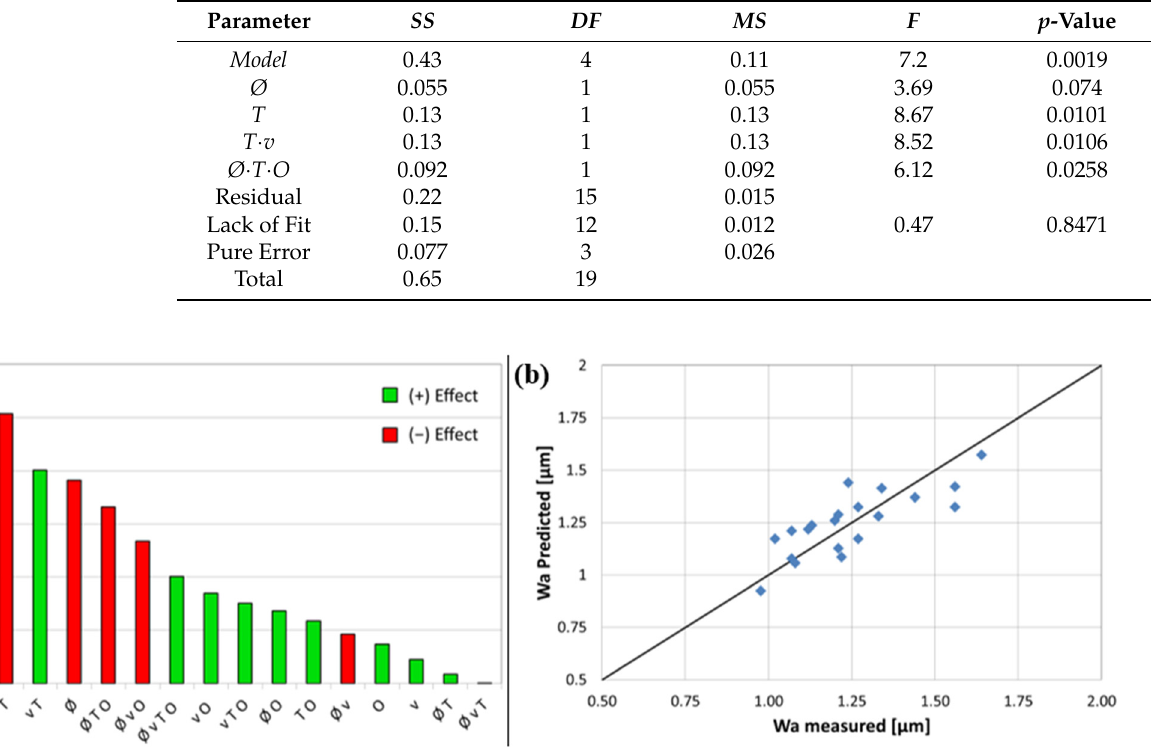
Figure 8. ( a ) Bar charts showing the half-effects of the parameters and interactions in decreasing order for Wa . A positive effect means an increase in the parameter leads to an increase in the waviness, a negative effect does the opposite. ( b ) Wa predicted with the waviness model versus actual measured values.